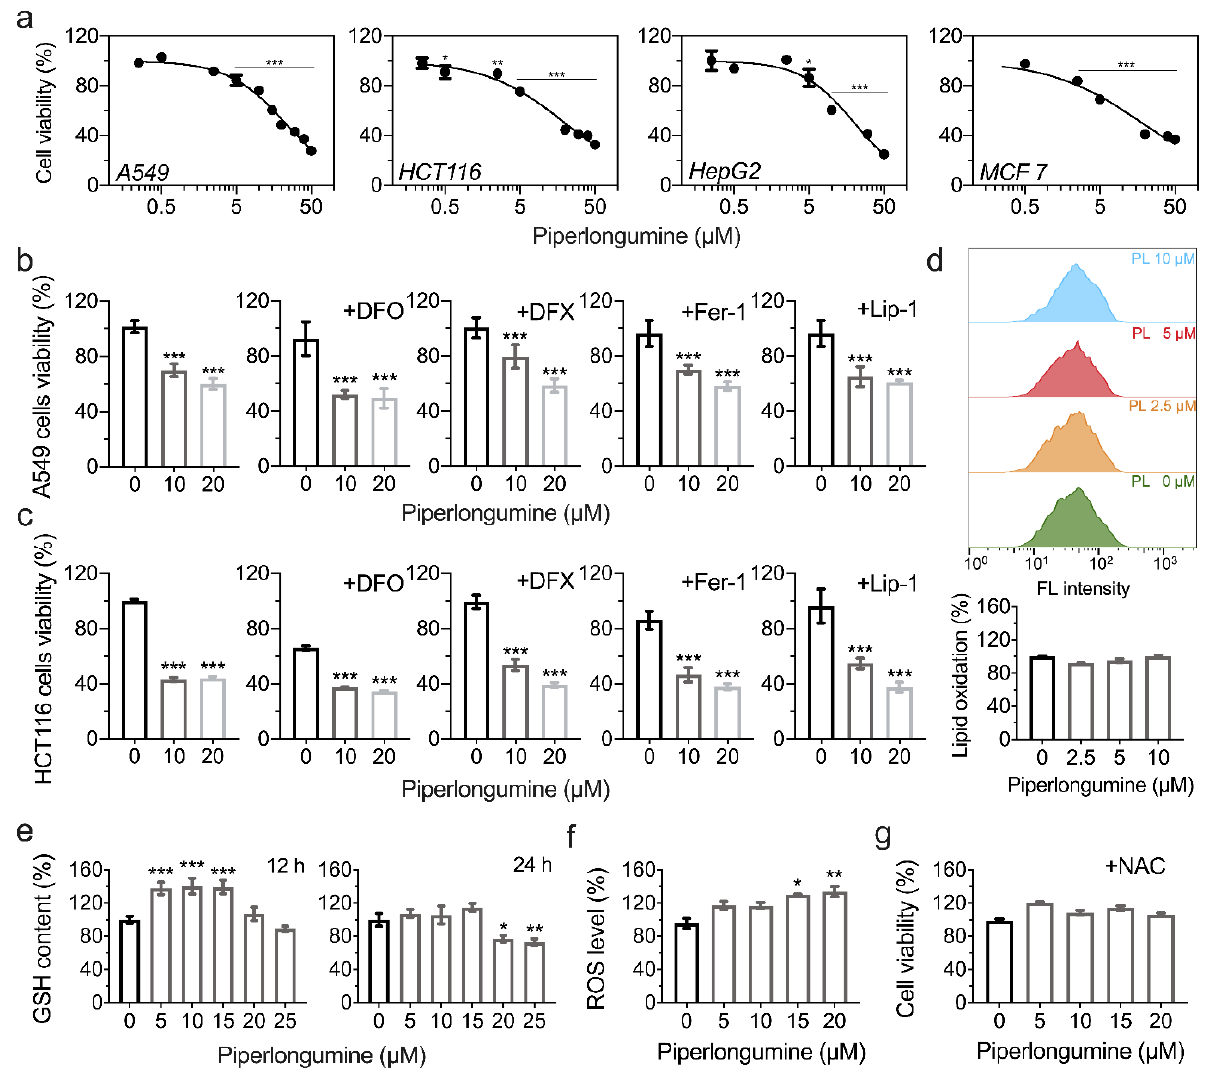
Figure 4. Piperlongumine induces cancer cells death. ( a ) Cytotoxicity of piperlongumine on cancer cell lines. A549, HCT116, HepG2, and MCF-7 cells were treated with piperlongumine in the range of 0 to 50 µ M for 24 h, and then the cell viabilities were determined by the CCK-8 assay. ( b , c ) Ferroptosis inhibitors do not rescue the cell death caused by piperlongumine in A549 and HCT116 cells. ( d ) Piperlongumine does not induce ferroptosis in HCT116 cells. The lipid oxidation induced by piperlongumine was measured by BODIPY TM 581/591 C11 using flow cytometry. ( e ) GSH contents in HCT116 cells upon piperlongumine treatment. ( f ) Increased ROS levels caused by piperlongumine in A549 cells. ROS level was determined by fluorescence probe DCFH-DA and monitored by a fluorescence microplate reader. ( g ) NAC protected A549 cells from